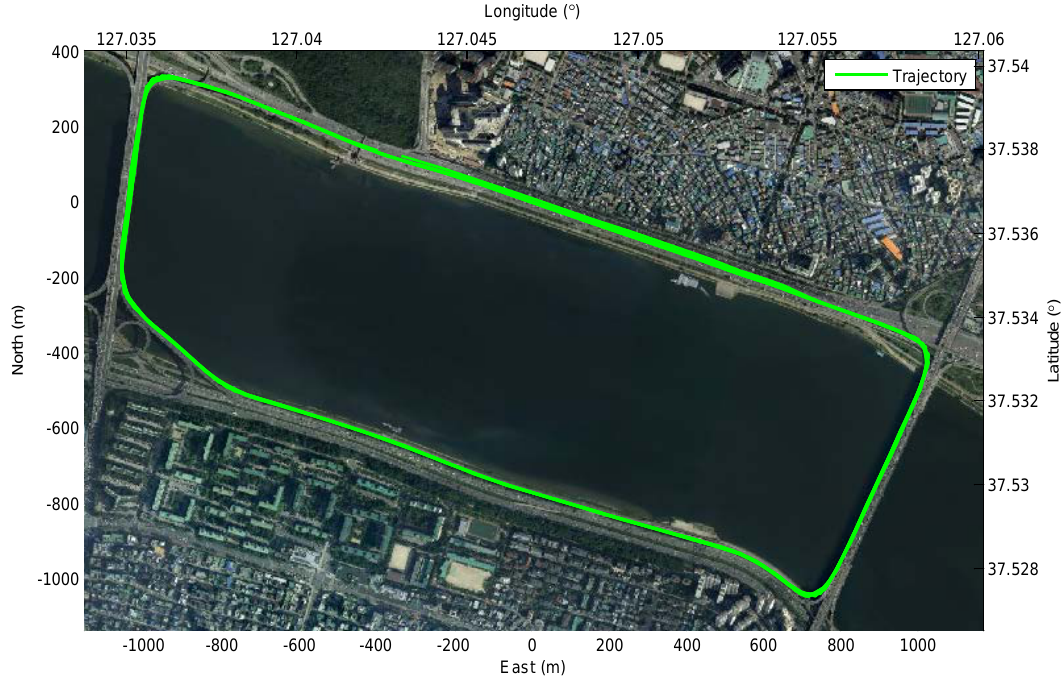
Figure 9. Test site for experiment: motorway road in